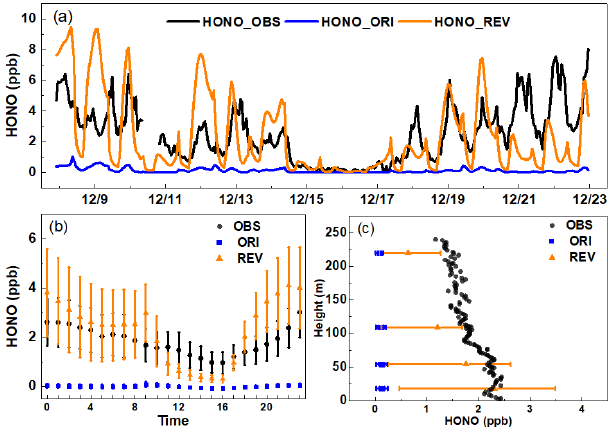
Figure 1. A comparison of simulated and observed HONO con- centrations in Beijing: (a) time series, (b) diurnal variation, and (c) vertical comparison. Error bars represent 5%–95% values of all HONO